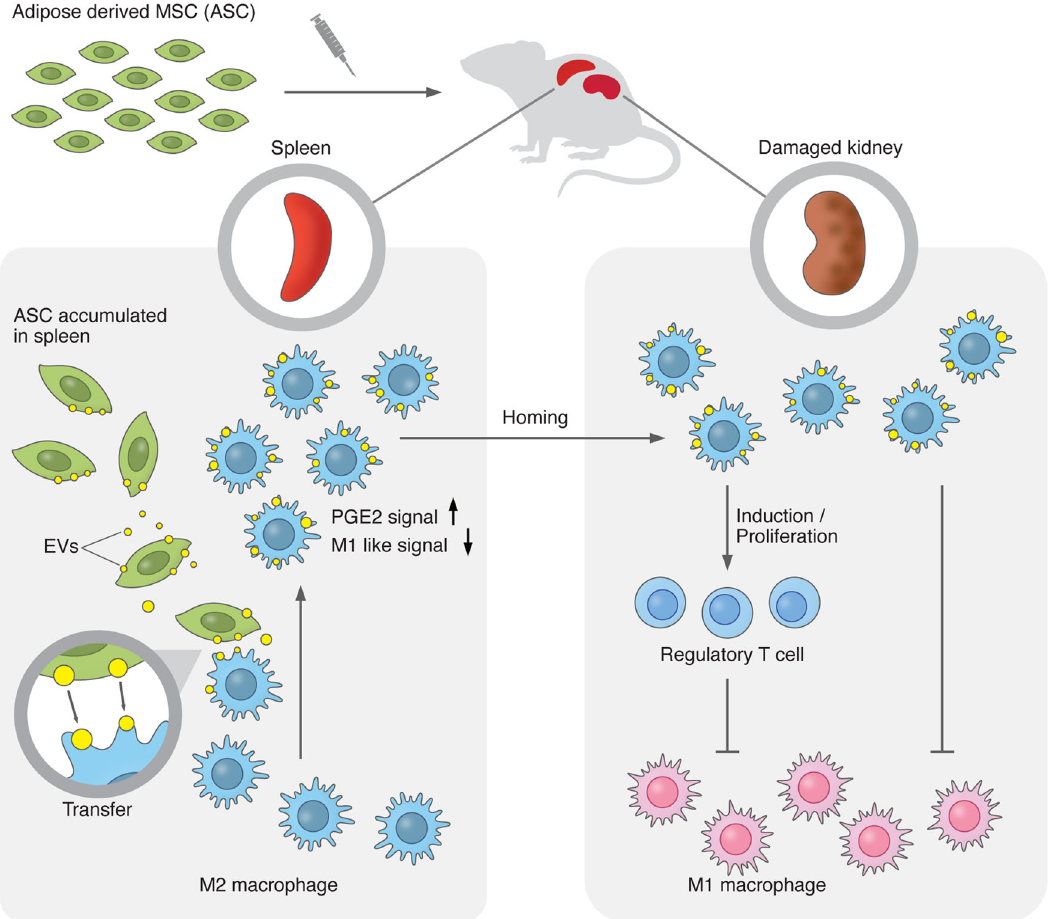
Fig. 9 Scheme of the proposed action of ASCs and ASC-derived EVs in nephritis. When ASCs are administered to rats with nephritis, ASC-derived EVs are transferred to M2 macrophages in the spleen, leading to macrophage activation via PGE2 stimulation and reduction of M1 signatures. EV-transferred M2 macrophages move from the spleen to the in fl amed kidney, resulting in the increase of Treg and decrease of M1 macrophages. ASCs exert renoprotection via EV-mediated modulation of M2 macrophages and the spleen-kidney